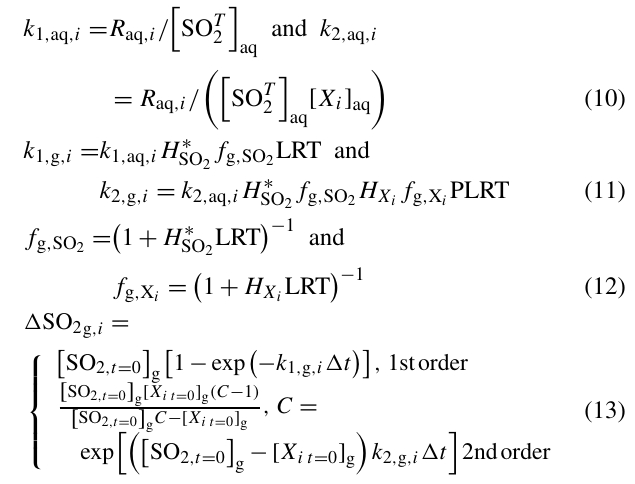
, k 1 , g ,i (s − 1 ) and ( g ) and H X indicate their SO 2 i and f g ,Xi are the gas-phase 2